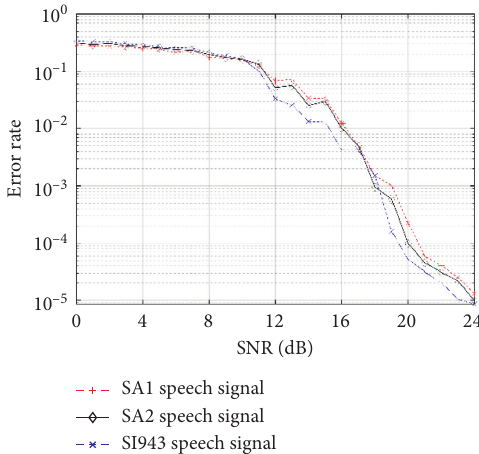
Figure 18: Bit error rate of speech signal.